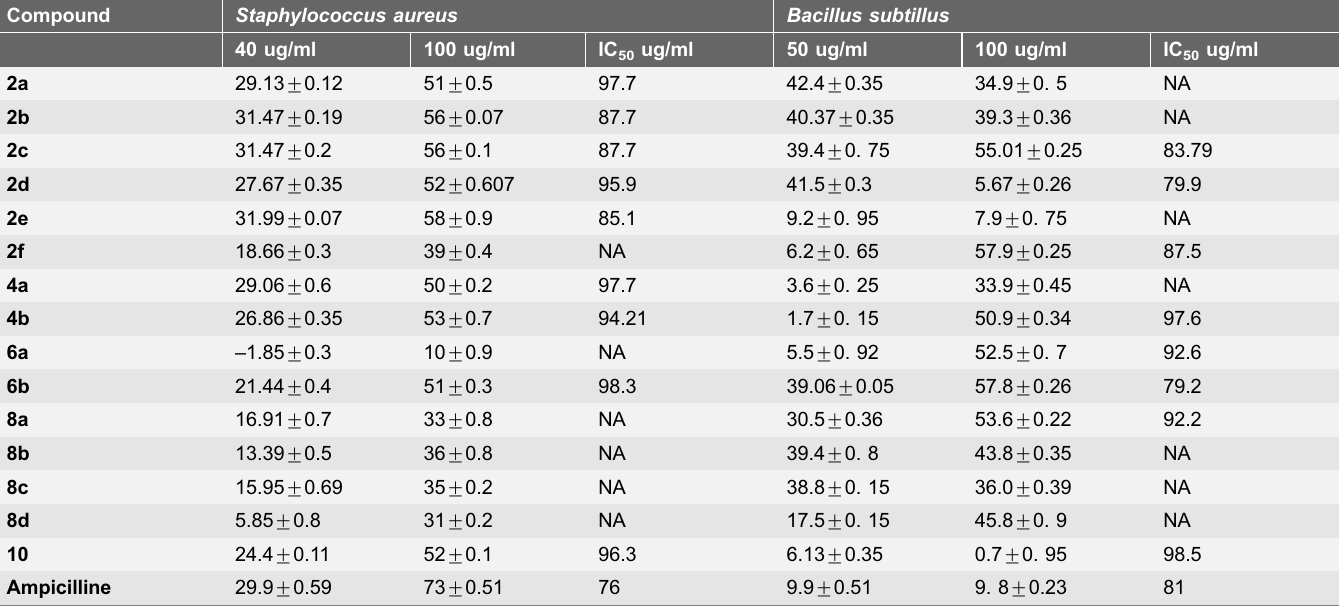
Table 8. Antibacterial activity of (prop-2-ynyloxy)benzene